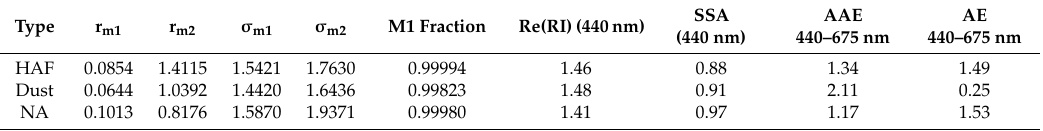
Table 3. Integrated optical properties for HAF, dust and NA aerosol types. Optical properties were obtained by averaging inversion data categorized for the three aerosol types. The entire global AERONET inversion dataset was used for the calculation. The mean radius (r) and standard deviation of r ( σ ) represent a bimodal number size distribution and the M1 fraction indicates the fraction of the total number concentration corresponding to fine particles (mode 1). Re(RI) is the real part of the refractive index; this value is fixed in LUT simulations for each aerosol type. The imaginary part of the refractive index is adjusted to account for SSA variations in the LUT simulations. The single scattering albedo (SSA), absorbing Ångström exponent (AAE) and Ångström exponent (AE) are the nominal value for each aerosol type obtained from the AERONET inversion dataset.